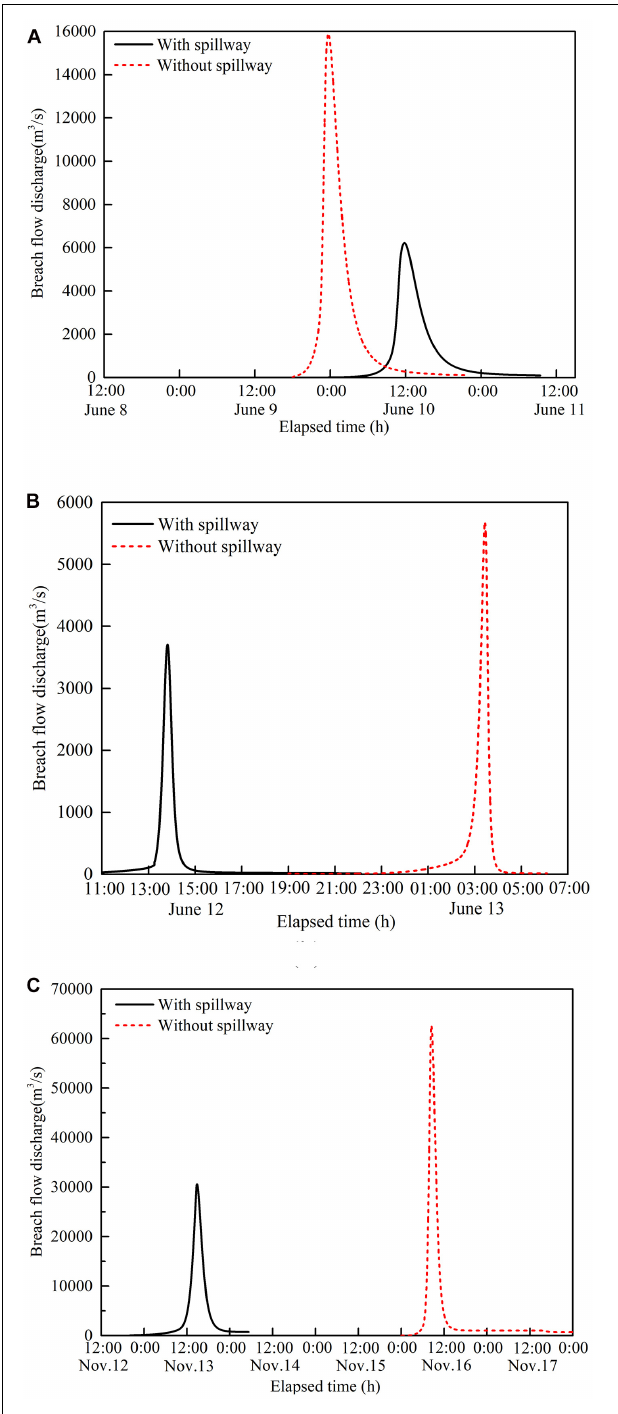
FIGURE 9 | Breach hydrographs with and without spillway excavation for the three landslide dams.